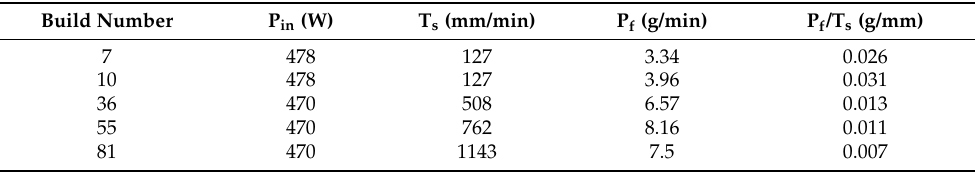
Table 2. Measured parameters of selected beads for building the multilayered